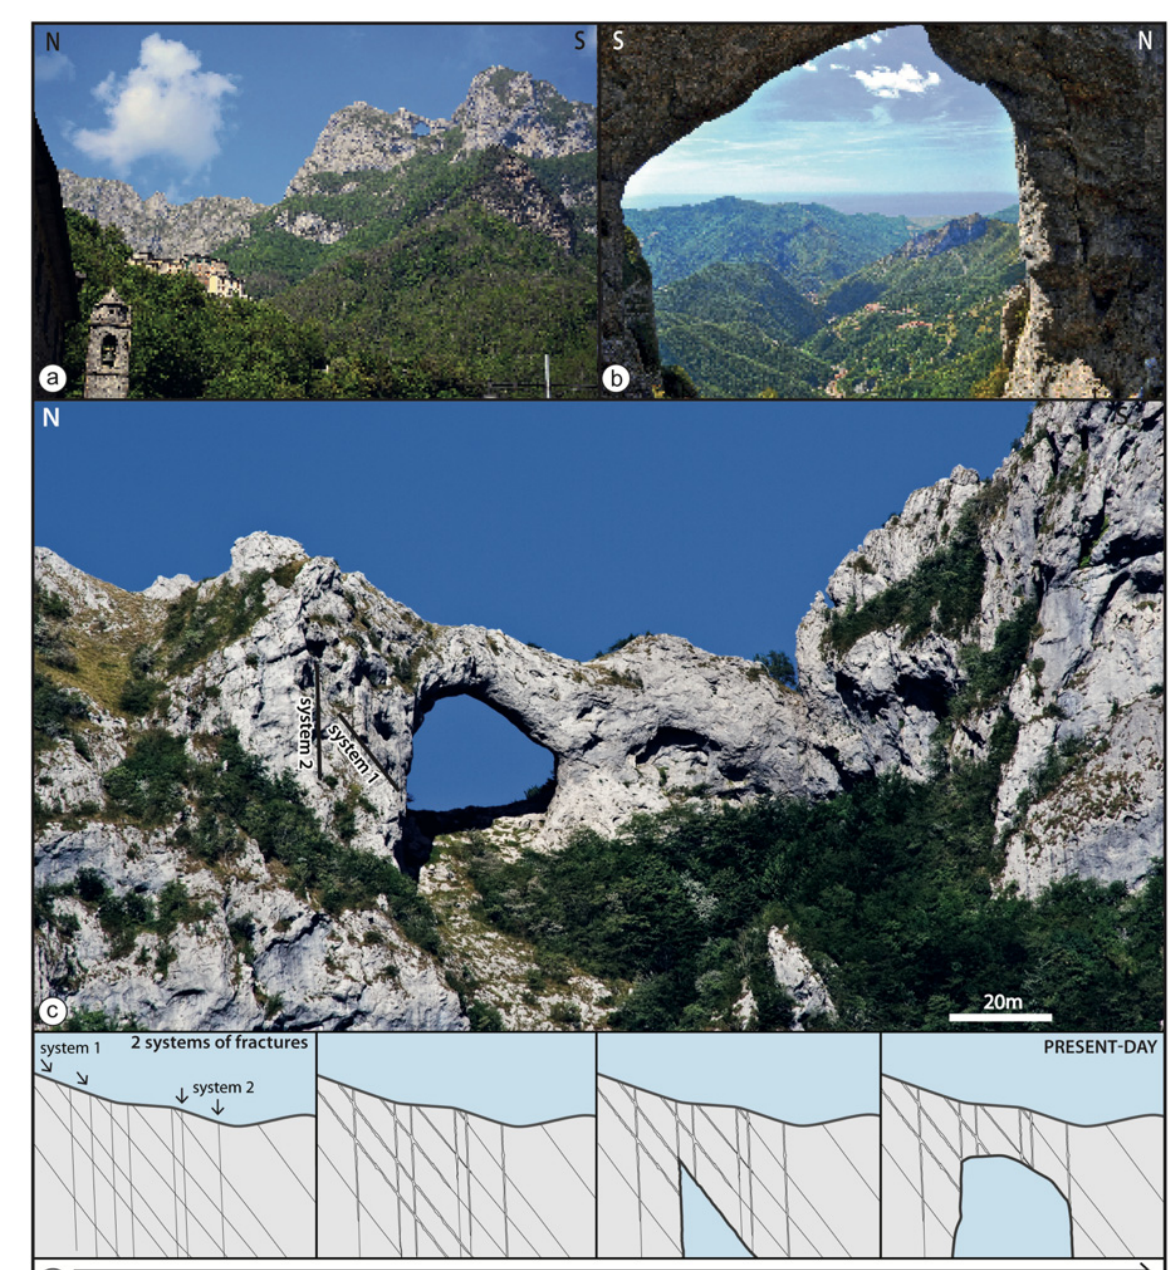
Figure 6. Mt. Forato Arch geosite. ( a ) Landscape view of the Mt. Forato Arch from the location of the interpretative panel in Cardoso (Stazzema, Lucca) (i.e., from SW toward NE); ( b ) Landscape view toward the Tyrrhenian Sea from below the arch; ( c ) Detailed view of the Mt. Forato Arch. The two main system of fractures triggering the development of the arch are also shown; ( d ) Evolutive sketch model of the Mt. Forato Arch.